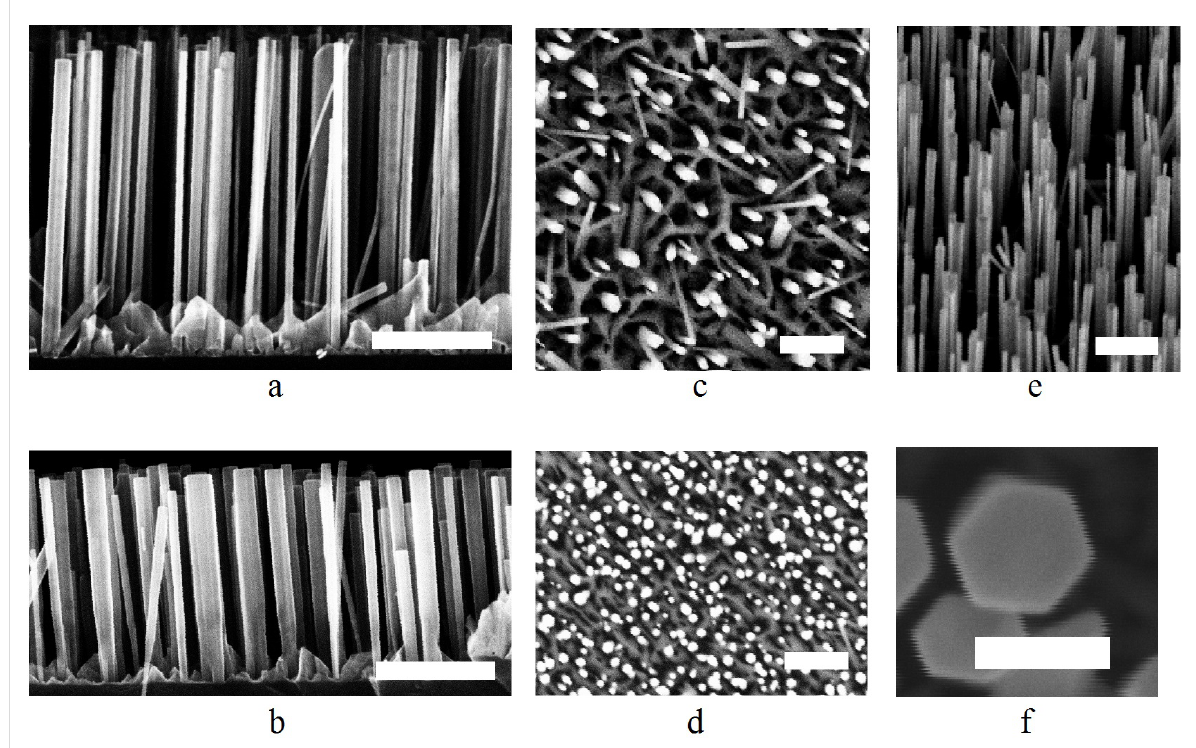
Figure 1: Scanning electron microscope (SEM) images of the nanowire (NW) arrays: a) image of the array grown on the substrate that underwent low temperature annealing (850 °C, sample 2); b) images of the array grown on the substrate that underwent high temperature annealing (1000 °C, sam- ple 7); c) top view image of the sample 2; d) top view image of the sample 7 (clearly indicating a higher surface density compared to sample 2); e) tilted view of the sample 2; f) enlarged view on the cross-section of a single NW. The scale bar in all images is 400 nm, except for (f) where it is 100